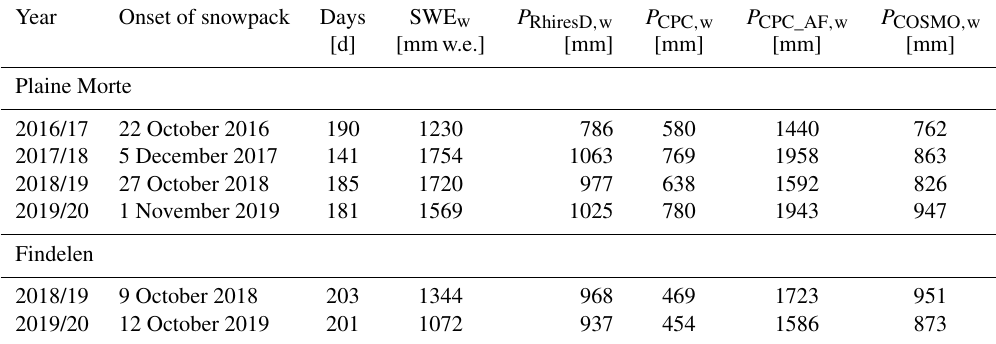
Table 1. Onset of the snowpack, number of days from the onset until 30 April (26 April for winter 2017/18 on Plaine Morte) and end-of- season amounts for the stations on Plaine Morte and Findelen. The end-of-season amounts are based on in situ SWE observations (SWE w ) and cumulative precipitation of RhiresD ( P RhiresD , w ), CombiPrecip ( P CPC , w ), CombiPrecip-adj ( P CPC_AF , w ) and COSMO-1 ( P COSMO , w ). Year Onset of snowpack Days SWE w P RhiresD , w P CPC , w P CPC_AF , w P COSMO , w [ d